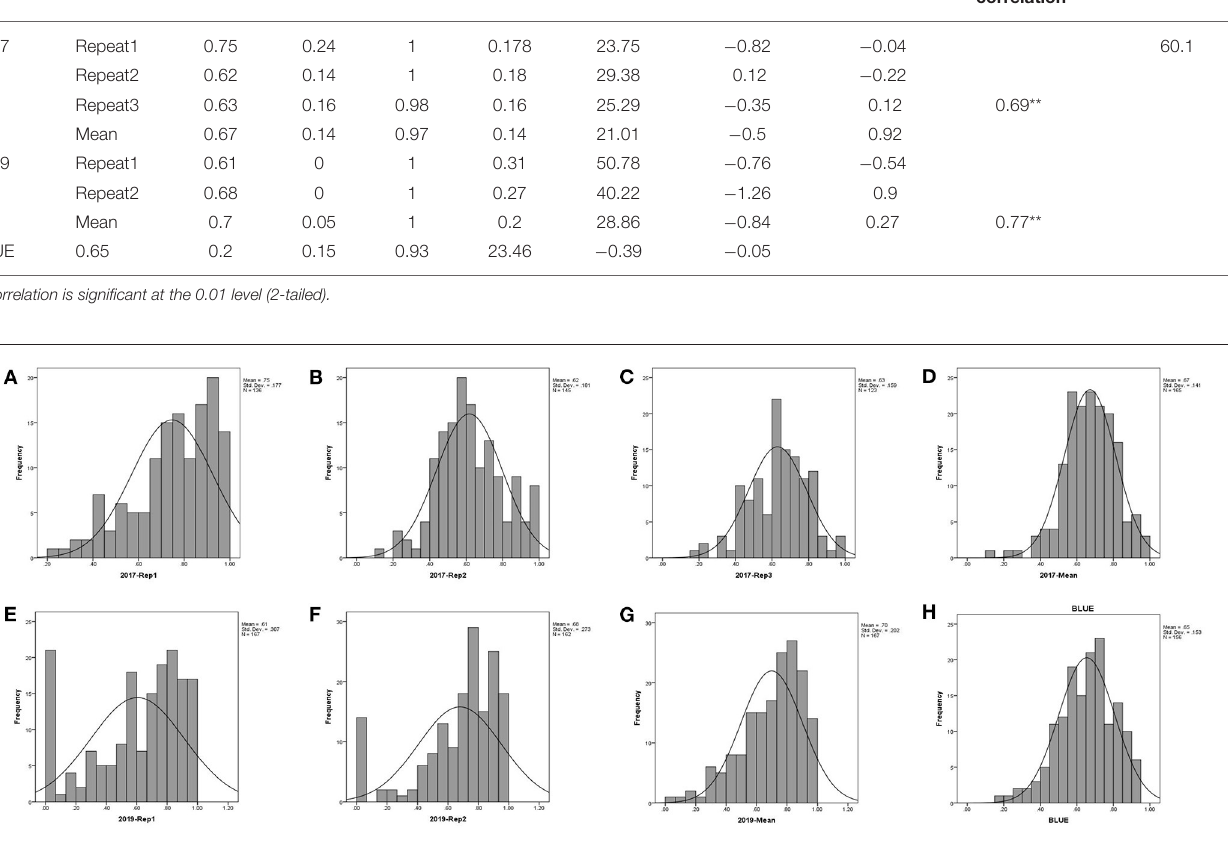
Frontiers in Agronomy |